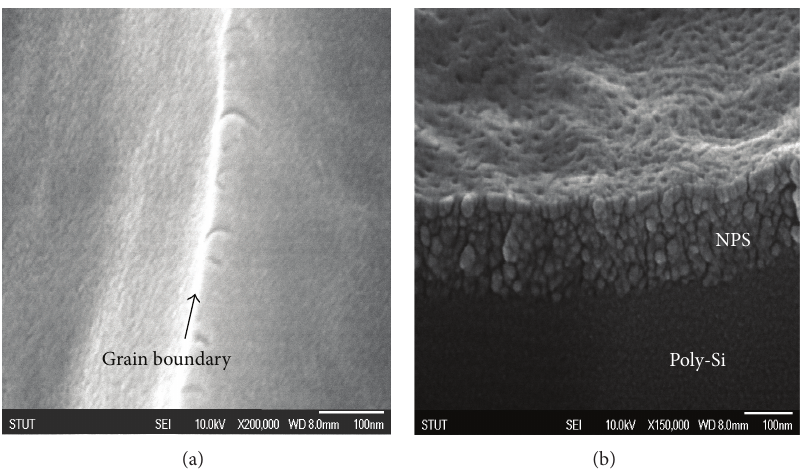
Figure 2: (a) The top view and (b) the cross-sectional view of SEM images of the developed NPS/poly-Si structure.